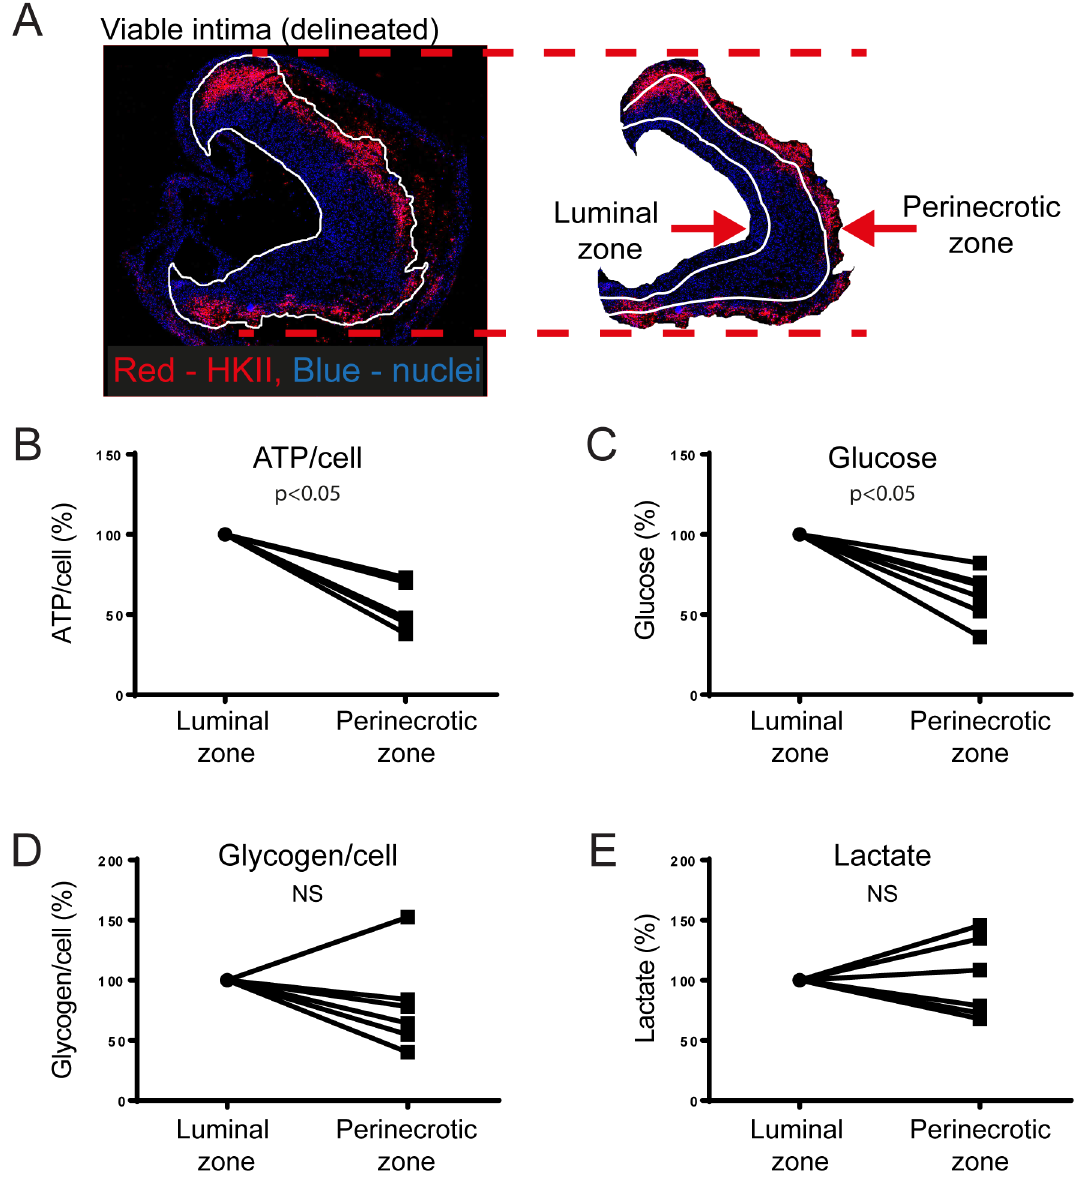
Fig 3. Severedepletion of ATP and glucose in perinecrotic zone of advanced plaques. A. Advancedatherosclerotic plaque,delineation in white of viableintima. Extract shows luminal(left) and perinecroticzone (right) of viable intima. Note high expressionof hexokinase II (HKII), indicativeof hypoxia,in perinecrotic zone. B and C. Lower concentrations of ATP (B) and glucose(C) in perinecroticzone (p < 0.05). D and E. No significantdifference in glycogen(D) and lactate concentrations (E) betweenluminaland perinecroticzone. n = 6,